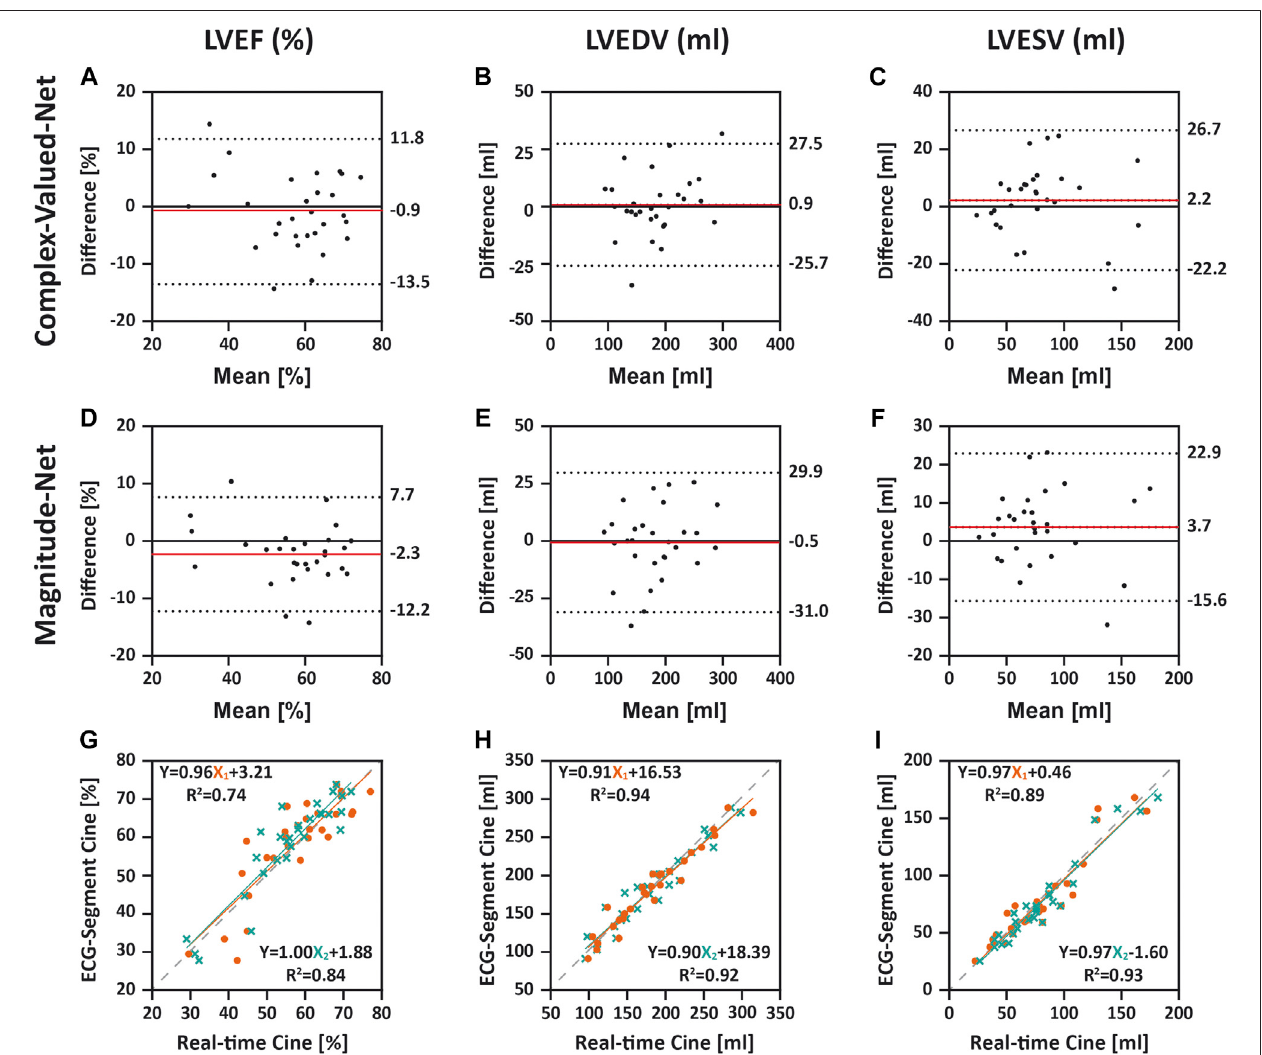
FIGURE 3 | Comparison between ECG-segmented cine and real-time cine for quantifying left-ventricular ejection fraction (LVEF), left-ventricular end-diastolic volume (LVEDV), and left-ventricular end-systolic volume (LVESV) using Bland – Altman analysis (A – F) and linear regression (G – I) . In Bland – Altman, dotted lines indicate upper and lower 95% limits of agreement and the red line represents the mean difference. The difference was calculated as real-time cine (Complex-Valued-Net and Magnitude-Net) minus ECG-segmented cine. In linear regression, X 1 and X 2 indicate real-time cine reconstructed by Complex-Valued-Net and Magnitude-Net, respectively. The dashed line shows a reference line with a slope of 1. All three quanti fi cations from real-time cine using both Complex-Valued-Net and Magnitude-Net had good agreement and high correlation with quanti fi cations by ECG-segmented cine (all p > 0.0167).